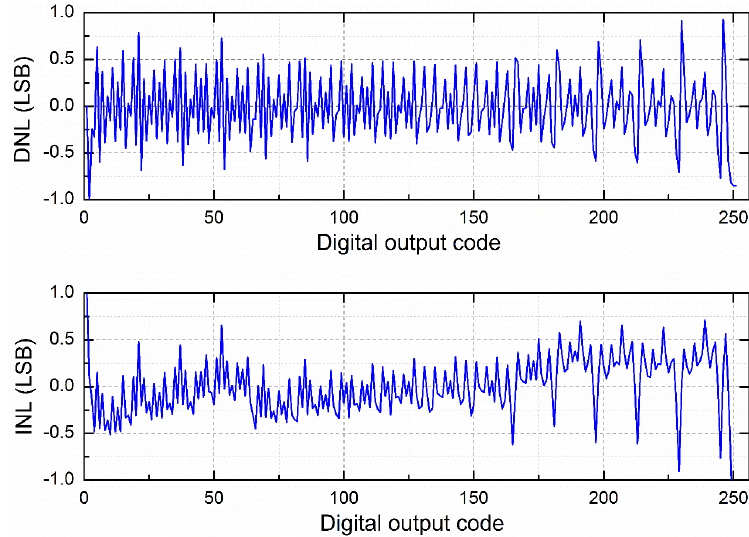
Figure 8. Measured differential non-linearity (DNL) and integral non-linearity (INL).